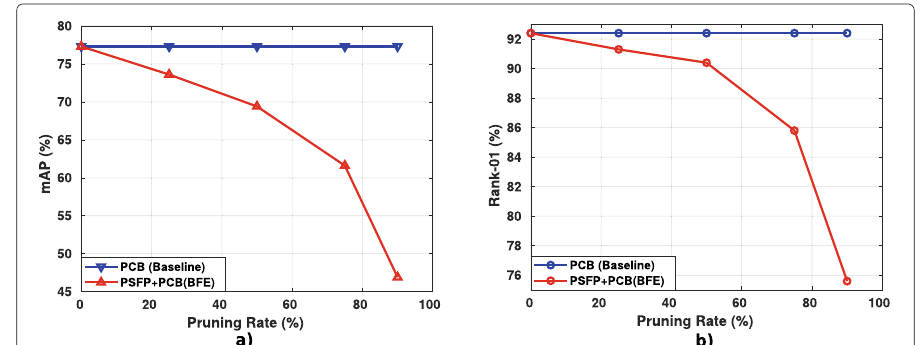
Fig. 4 Comparative ReID performance analysis of the PSFP+PCB(BFE) methods with different pruning rates for Market-1501 dataset: a mAP vs pruning rates and b Rank-01 vs Pruning rates